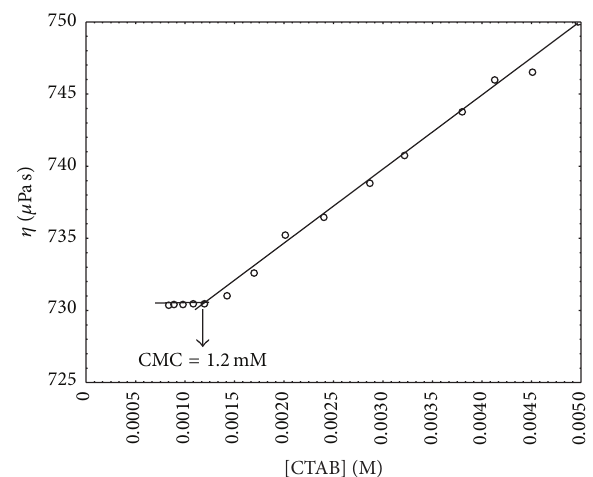
Figure 2: Viscosity versus surfactant concentration plot for CTAB in water at 308.15